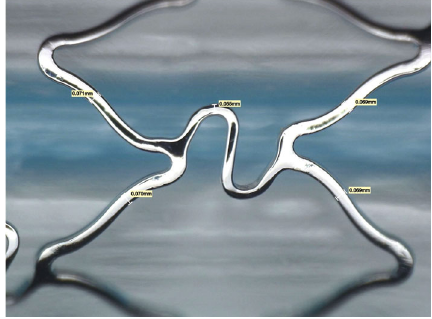
Figure 9: Strut of Osum 2 : 75 × 24 after expansion.